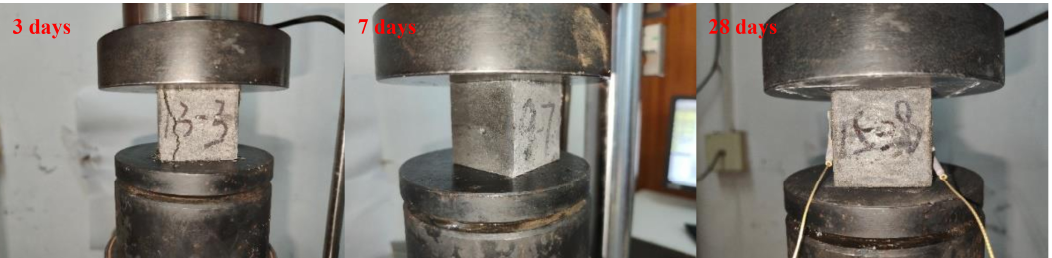
Figure 5. Uniaxial compressive strength test of 3 days, 7 days, and 28 days test block curing.